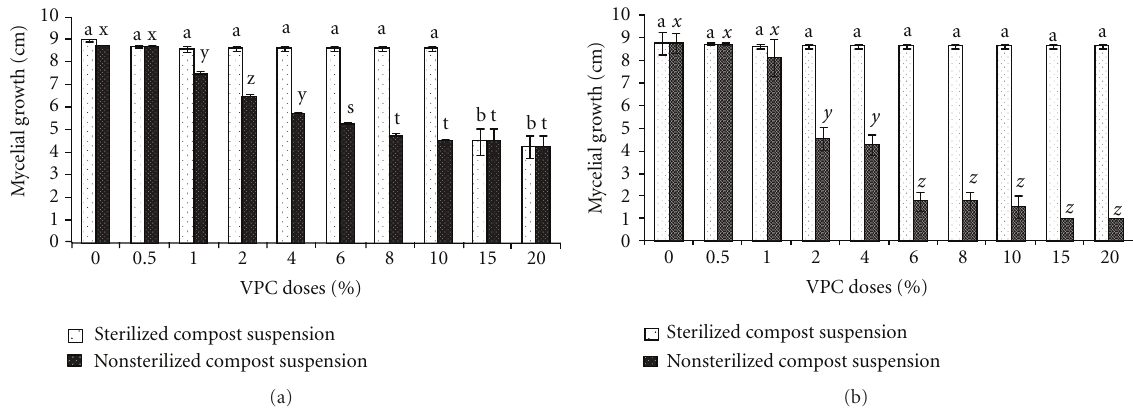
Figure 2: E ff ect of VPC extract (a) and volatiles produced by VPC extract (b) against Forl on mycelial growth of Forl.